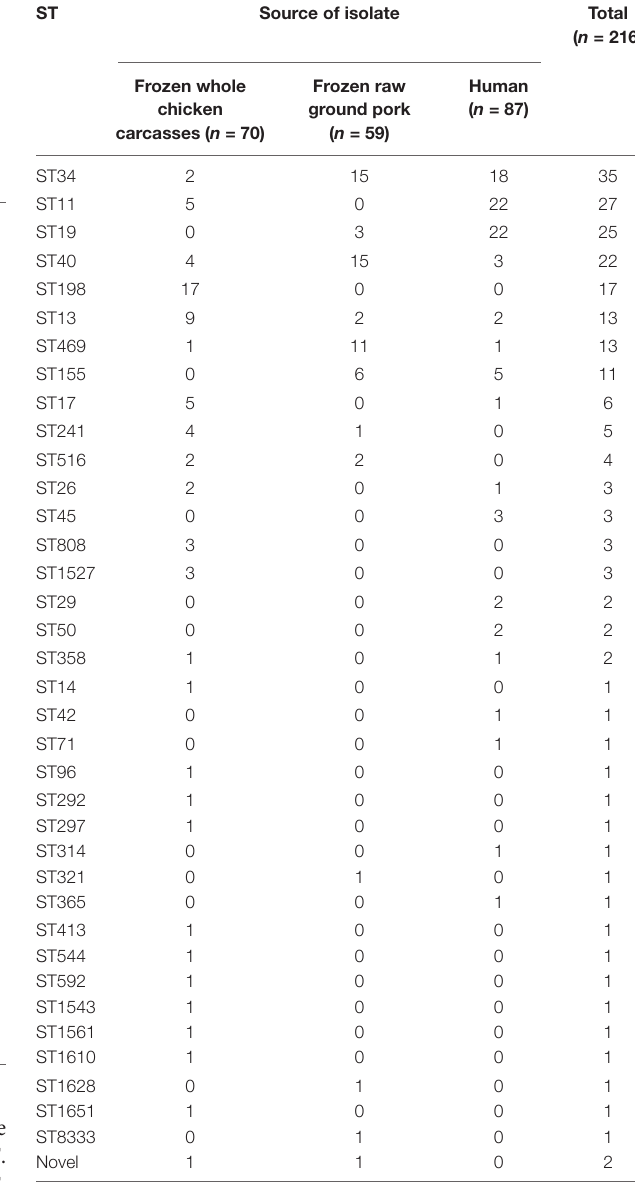
Figure 2 . Overall, serotyping is still serving as a gold-standard technique for routine typing in a common outbreak